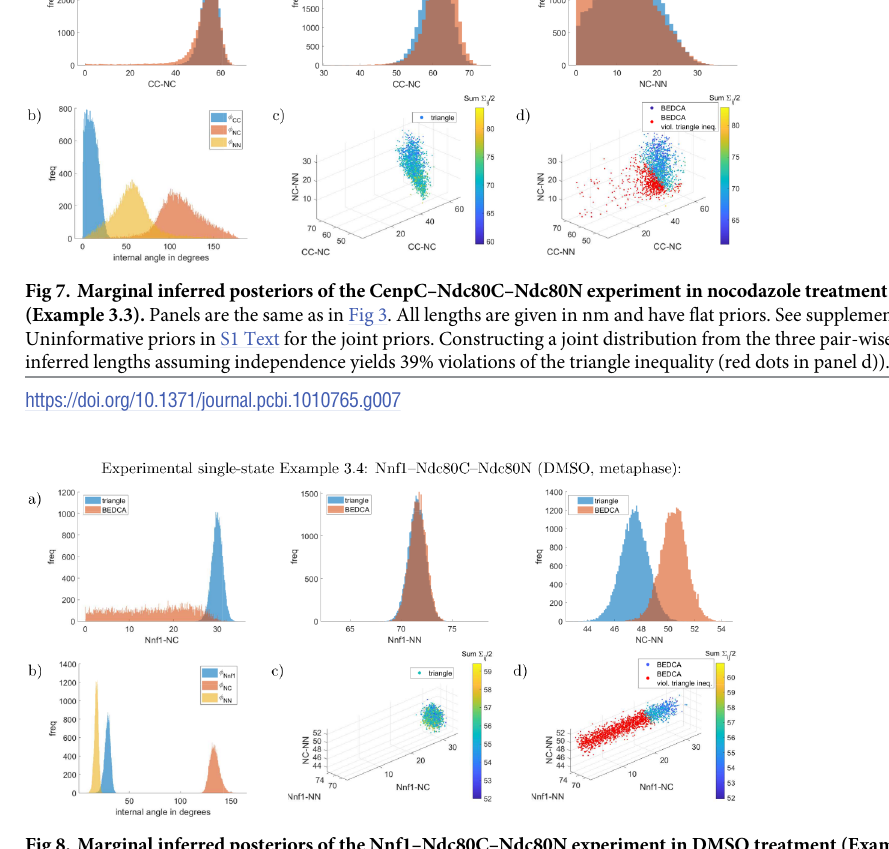
Fig 8. Marginal inferred posteriors of the Nnf1–Ndc80C–Ndc80N experiment in DMSO treatment (Example 3.4). Panels are the same as in Fig 3. All lengths are given in nm and have flat priors. See supplement Uninformative priors in S1 Text for the joint priors. Constructing a joint distribution from the three pair-wisely inferred lengths assuming independence yields 71% violations of the triangle inequality (red dots in panel d)).